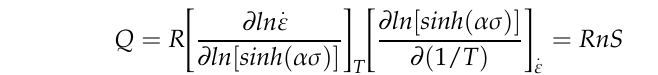
Figure 3. Linear relationship fitting: ( a ) ln 𝜀(cid:4662)– ln σ , ( b ) ln 𝜀(cid:4662)– σ , ( c ) ln 𝜀(cid:4662)– ln[sinh( ασ )], ( d ) 1000 / ln[sinh( ασ )] – 1000/T.